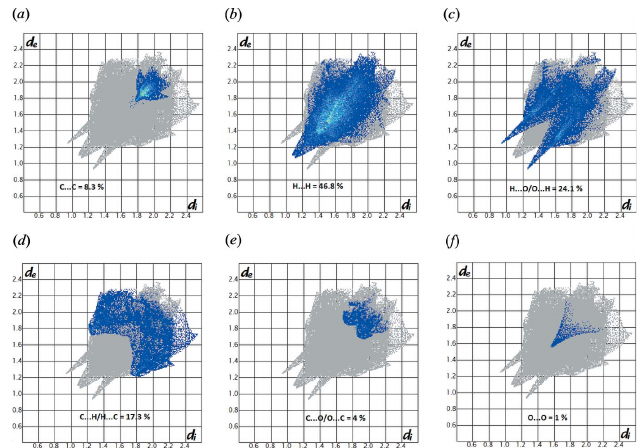
Figure 6 Decomposed two-dimensional fingerprint plots for compound (I). Various close contacts and their relative contributions are indicated.